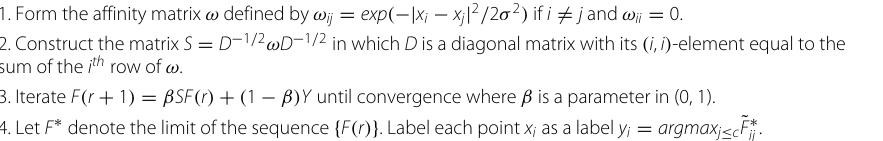
Table 2 The algorithm for the label spreading semi-supervised method (Zhou et al.